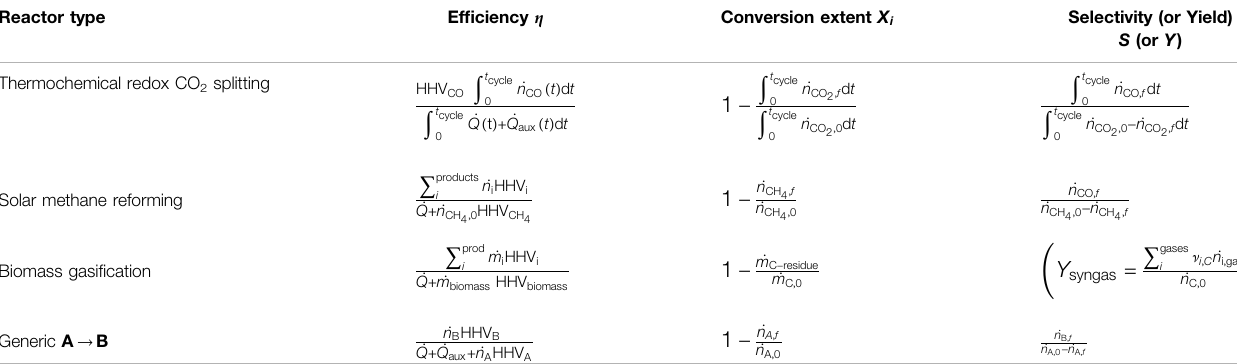
TABLE 2 | The performance indicatoars for the example solar fuel processes discussed in this work. Reactor